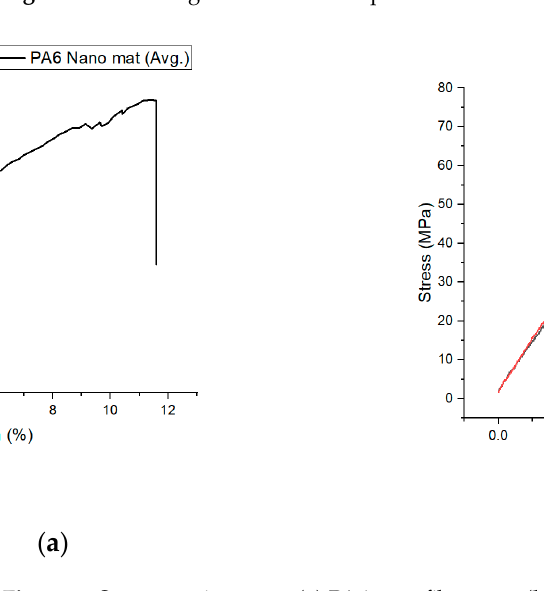
Figure 7. Stress–strain curve. ( a ) PA6 nanofiber mat; ( b ) epoxy and layered composite. Table 1. Mechanical properties of the PA6 nanofiber mat, epoxy, and layered composite.